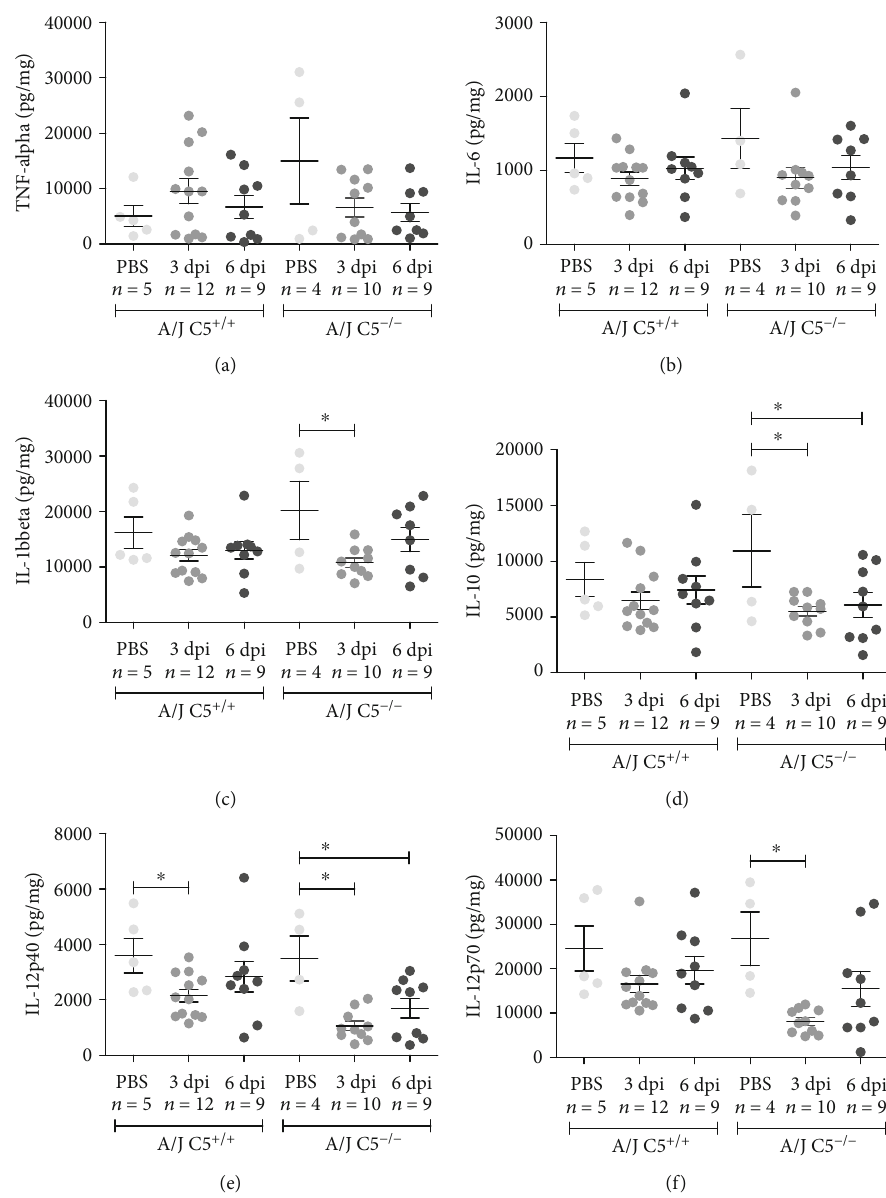
Figure 5: Lung concentrations of pro- and anti-in fl ammatory cytokines during early infection by LPF. A/J C5 +/+ and A/J C5 -/- mice were inoculated i/p with 1 : 5 × 10 8 LPF or PBS and then euthanized on the third or the sixth days. The concentrations of several cytokines were analyzed in the liver extracts by ELISA, using the same protein concentration in each sample. Signi fi cant di ff erences are indicated as ∗ when p < 0 : 05 . dpi: days